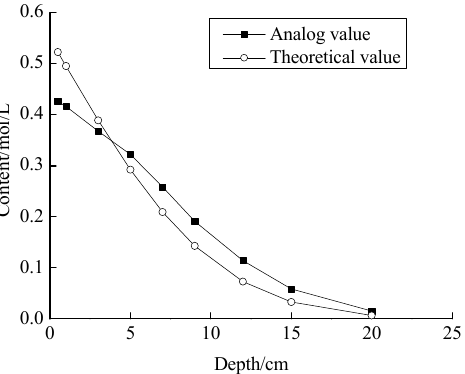
Figure 11. Comparison between simulated and theoretical values.